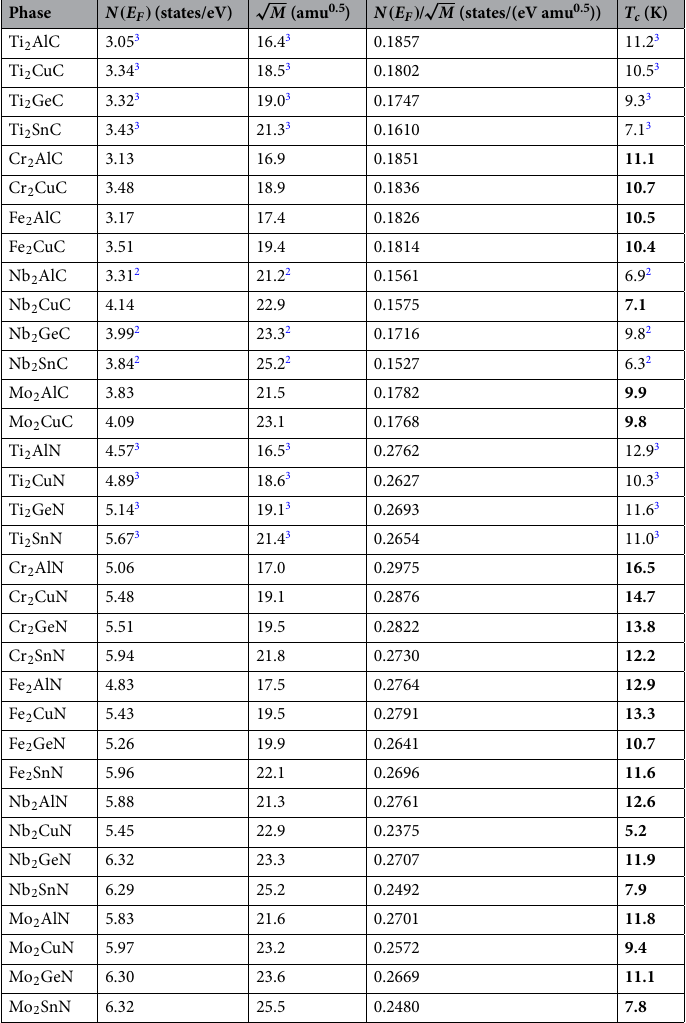
Table 3. Superconducting temperature values of M 2 AC (M: Ti, Cr, Fe, Nb and Mo; A: Al, Cu, Ge and Sn; X: C and N) phases screened by the high-throughput Fröhlich model. Predicted T c for Nb 2 AC (A: Al, Cu, Ge and Sn) and Ti 2 AX (A: Al, Cu, Ge and Sn; X: C and N) are taken from our previous publications 2, 3 . The new predicted T c values based on the results in this paper are given in bold.